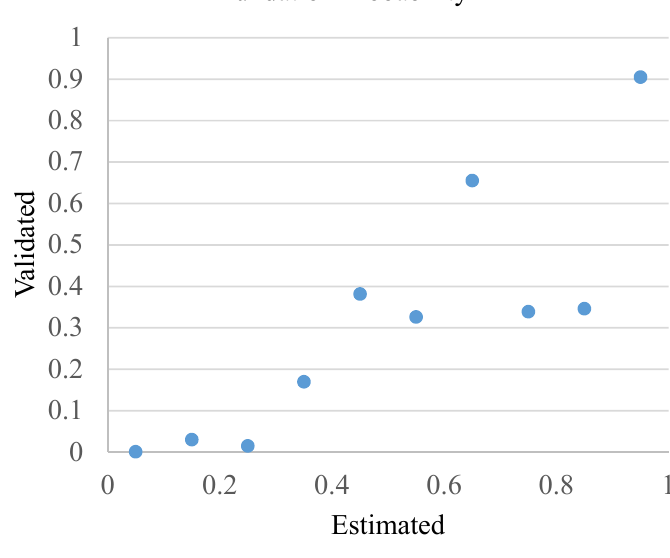
Figure 19. Estimated and validated probability. Table 3. The number of pixels for different predicted probability intervals.